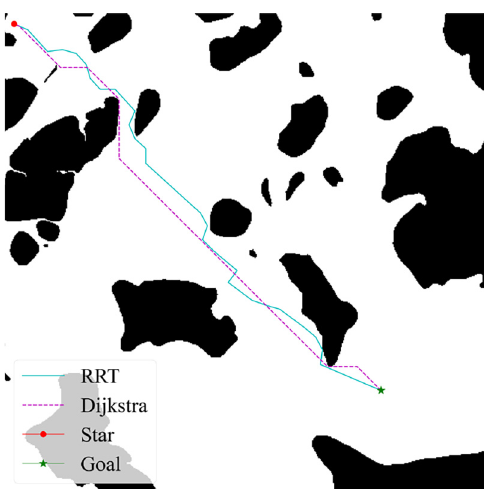
Figure 11 Path planning results under different algorithms